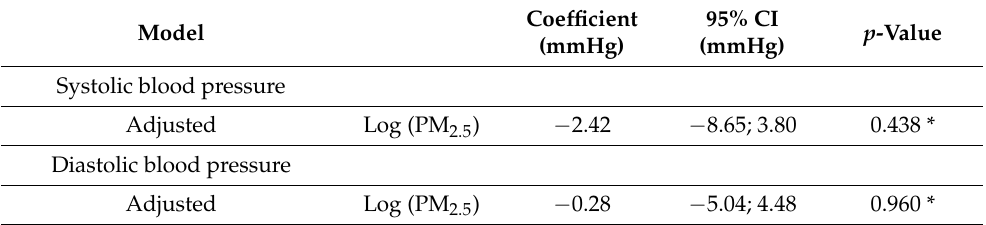
Table 3. Relationship between systolic and diastolic blood pressure (mmHg) and PM 2.5 ( µ g/m 3 ) adjusting for important